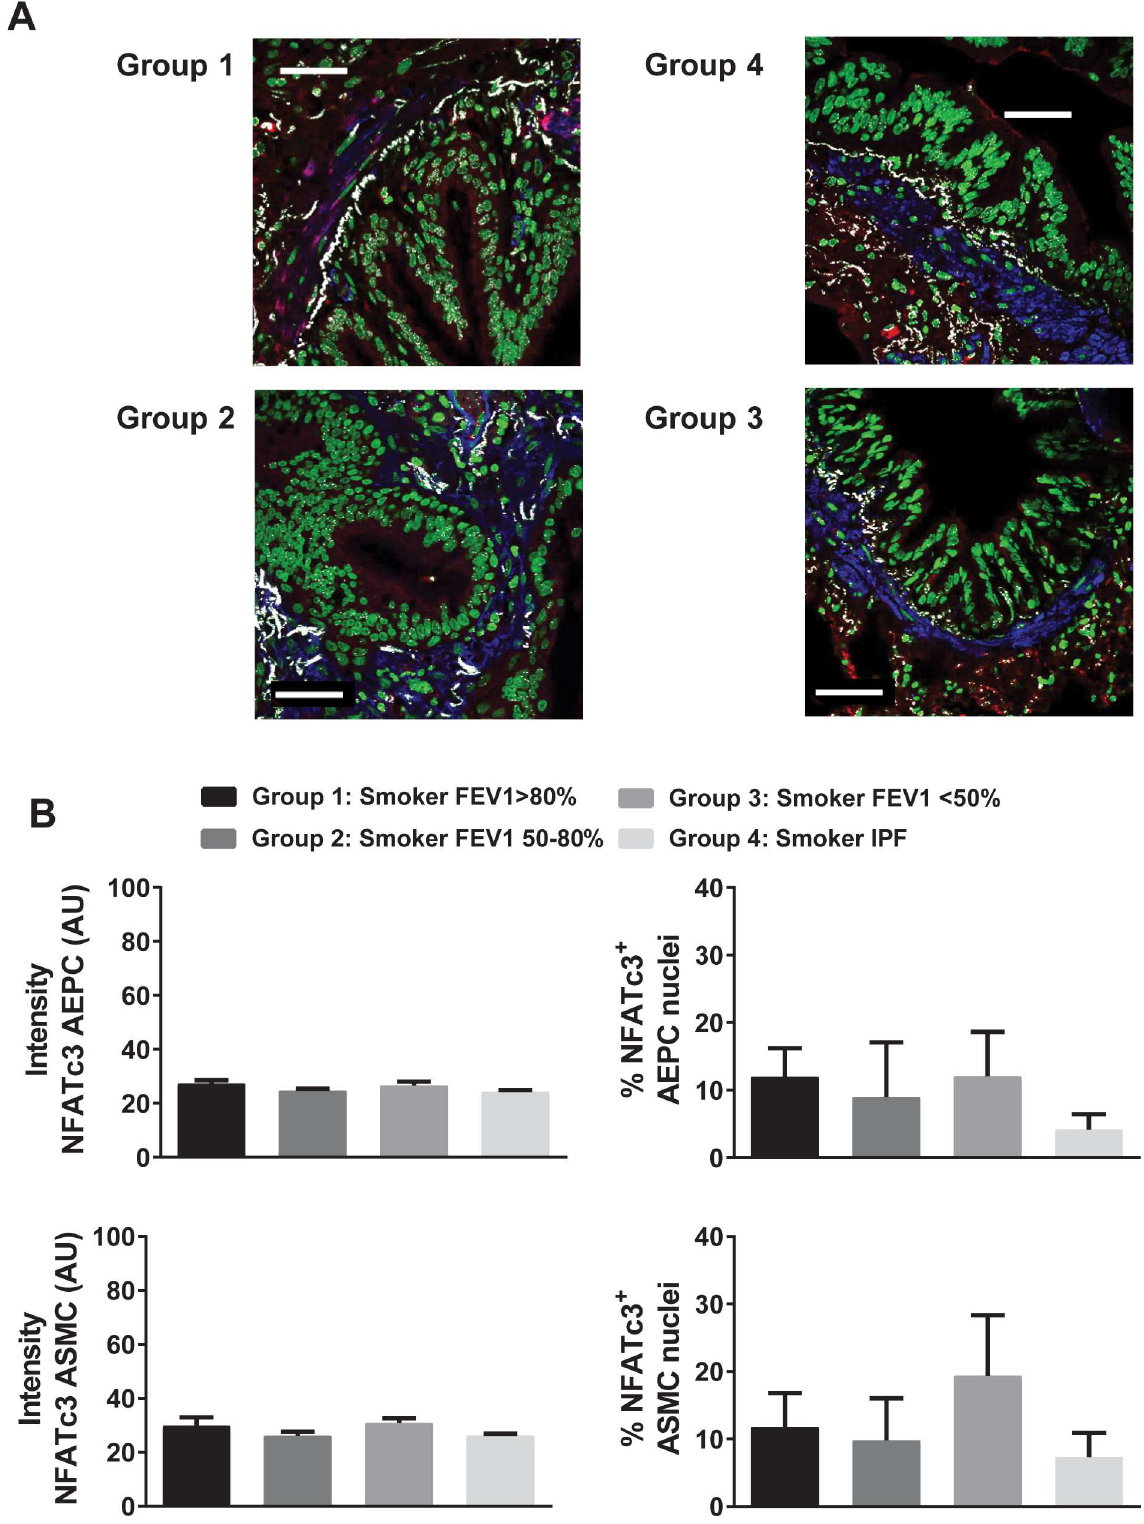
Fig 5. NFATc3 activity and expressionin airway epithelial and smooth muscle cells from lungs from COPD and IPF patients. A) Representative images of NFATc3 (red) and smooth muscle alpha-actin(blue) immunostainingof lung sections of patients from groups 1–4. Nuclei were stained with Sytox green. NFATc3 nuclearco-localization is shown in white. Scale bar =